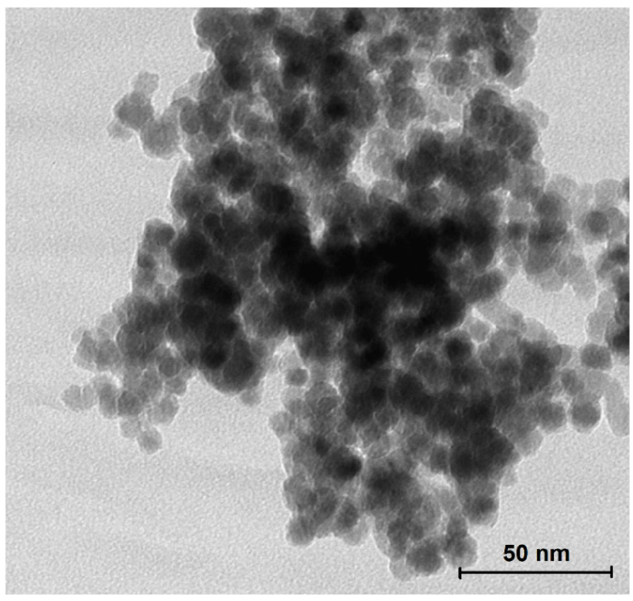
Figure 3. TEM image of drop-cast CdS nanoparticles.